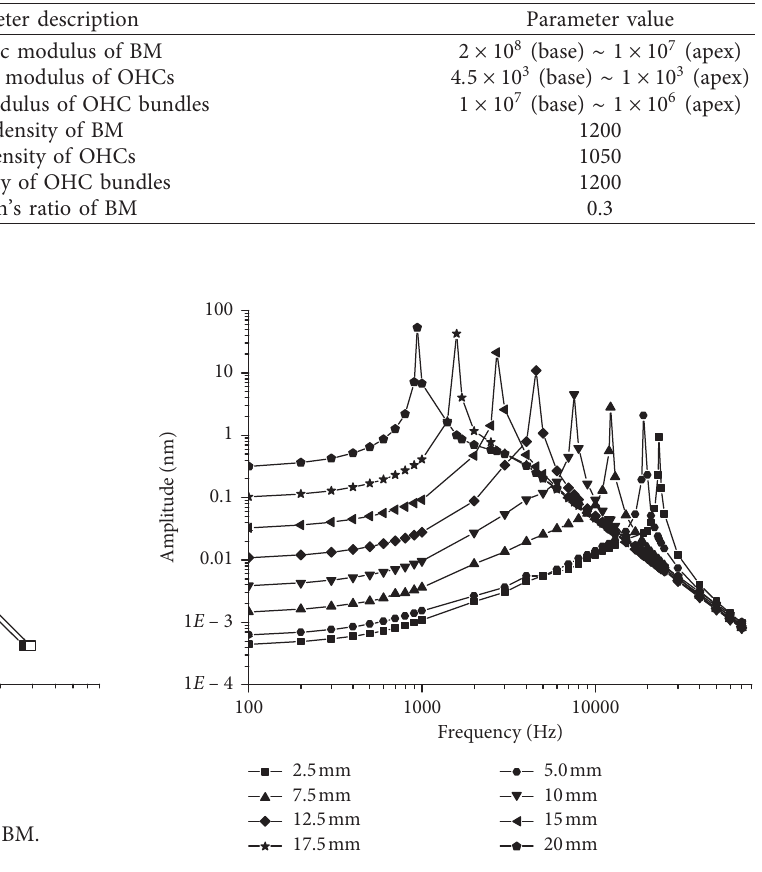
Table 2: Material properties of the microstructure of OC.